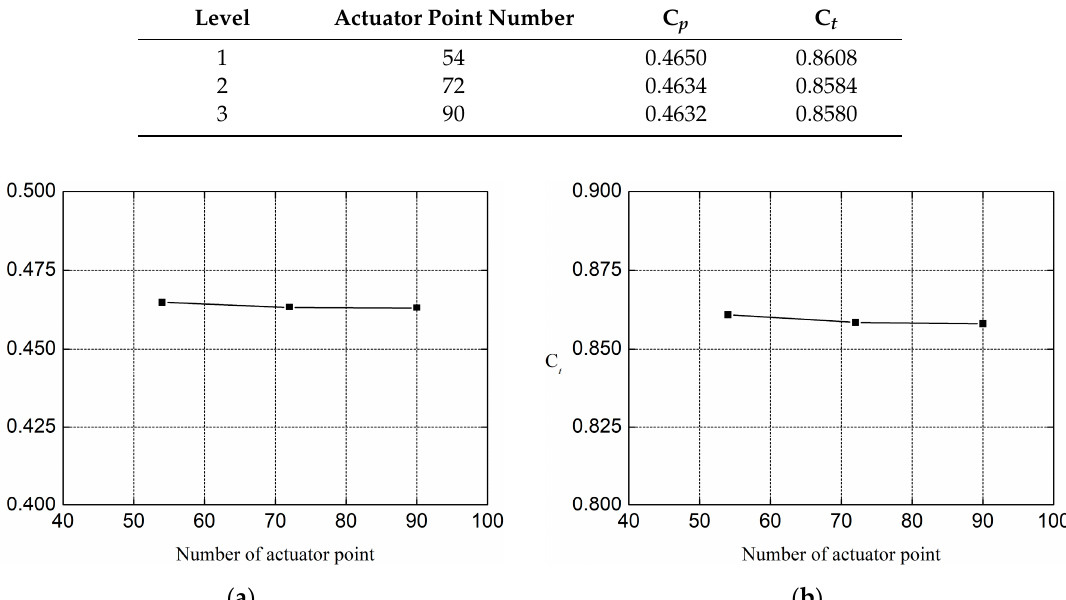
Figure 8. Relationship between actuator point number and aerodynamic coefficient, ( a ) power coefficient, and ( b ) thrust coefficient.